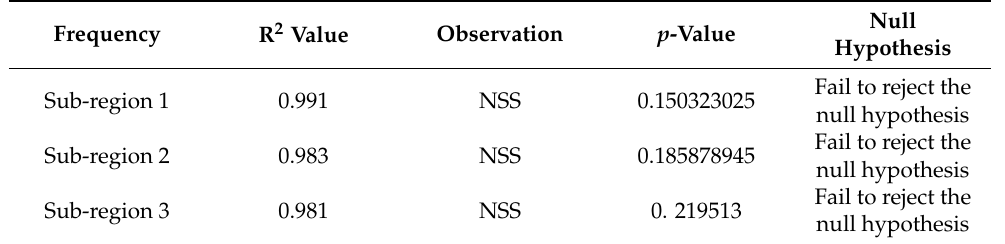
Table 8. Case study 2 ANOVA results.